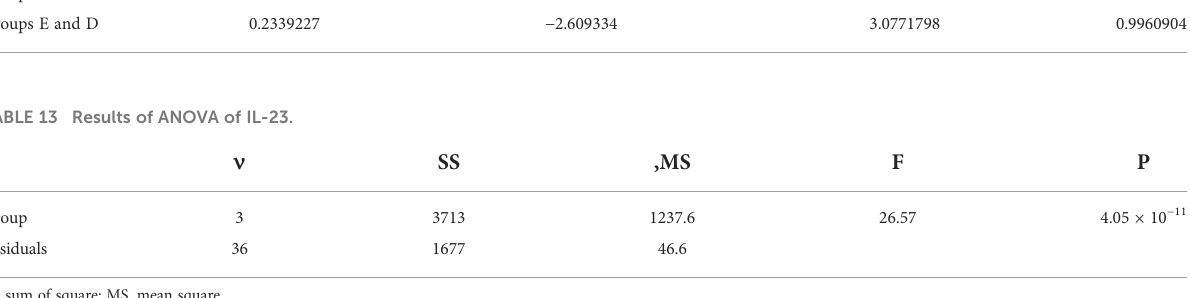
TABLE 14 Results of pairwise comparison of